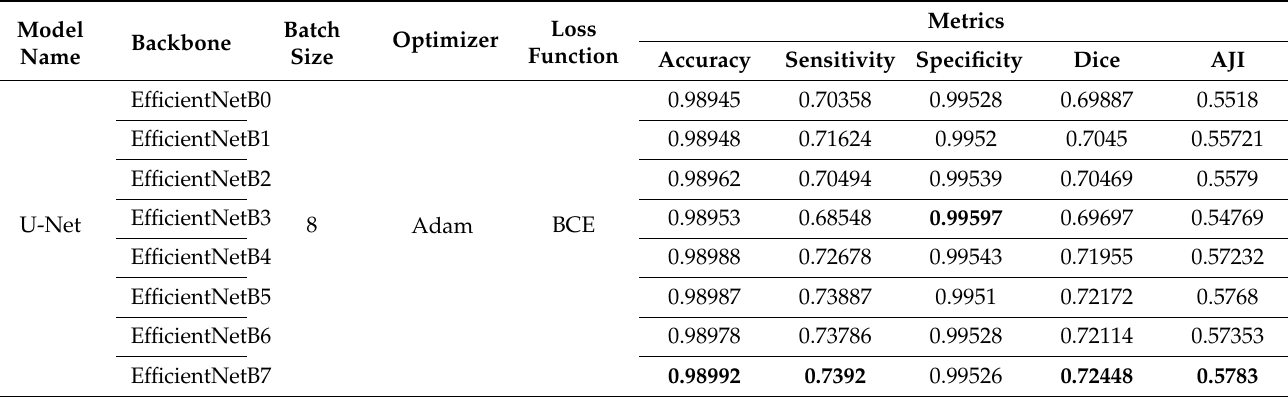
Figure A1. The box plots of Dice and AJI scores for all the test data sets. Different boxes with colours represent the different backbones of the U-Net model with the batch size of 4. The median value of every box is the red line inside the box; the outliers are labelled as the red (+) symbol. Table A2. A performance comparison of U-Net with the different backbone versions of EfficientNet (bold represent the best